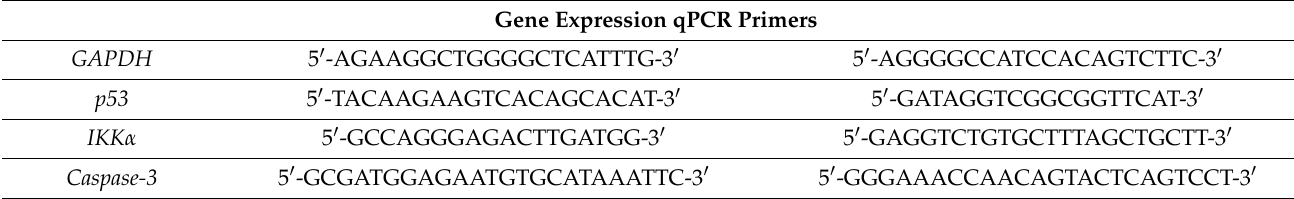
Table 1. List of primers used in